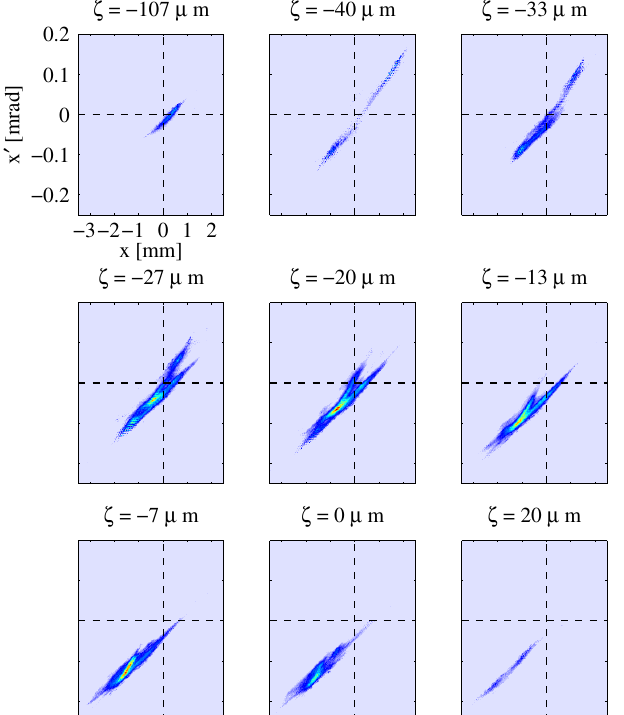
FIG. 17. (Color) Reconstructed horizontal phase space distribu- tions of selected slices. The longitudinal position of the individ- ual slices is indicated on top of the images. The charge density scale is the same in each image. Note that the origin (0, 0) is defined by the centroid of the charge distribution of the entire bunch, compare Fig. ficial for the FEL gain. A core emittance of a few (cid:1) m and a peak current in the order of 1 kA were also found at electron energies of 677 and 964 MeV [28].